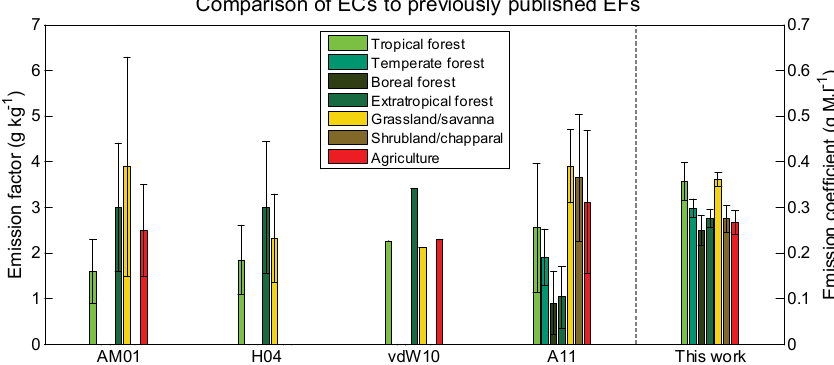
Fig. 8. Bar graph showing the different EFs (left y axis) in previous work and ECs (right y axis) presented here at the global biome scale. EFs from previous studies (from left to right) are: Andreae and Merlet (2001), Hoelzemann et al. (2004), van der Werf et al. (2010), Akagi et al. (2011). In previous work, error bars indicate one standard deviation of the mean; in the case of van der Werf et al. (2010), no standard deviation was reported. Error bars for this work indicate the standard error of the